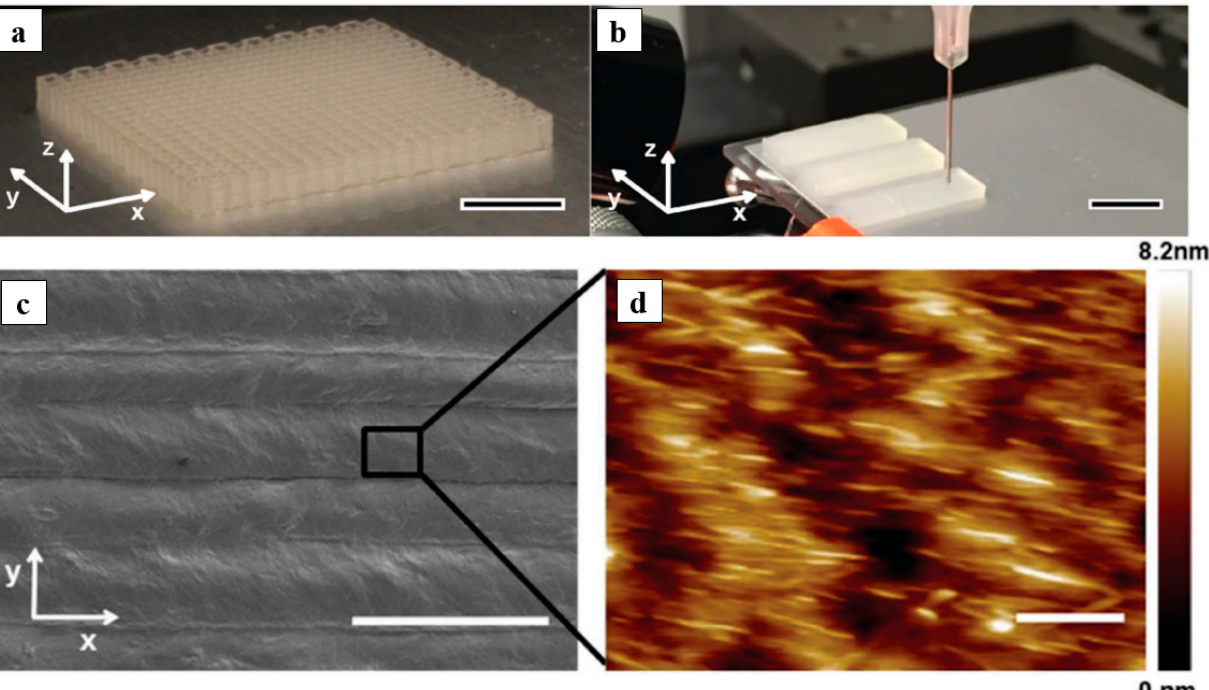
Figure 19. ( a , b ) Photograph of 3D printed grids and blocks with eight layers of parallel lines; ( c , d ) CNC alignment in 3D printed films: SEM (scale bar, 200 µm) and AFM topologies (scale bar, 100 ( c , d ) CNC alignment in 3D printed films: SEM (scale bar, 200 µ m) and AFM topologies (scale bar, µm). Reproduced from [118]. 100 µ m). Reproduced from